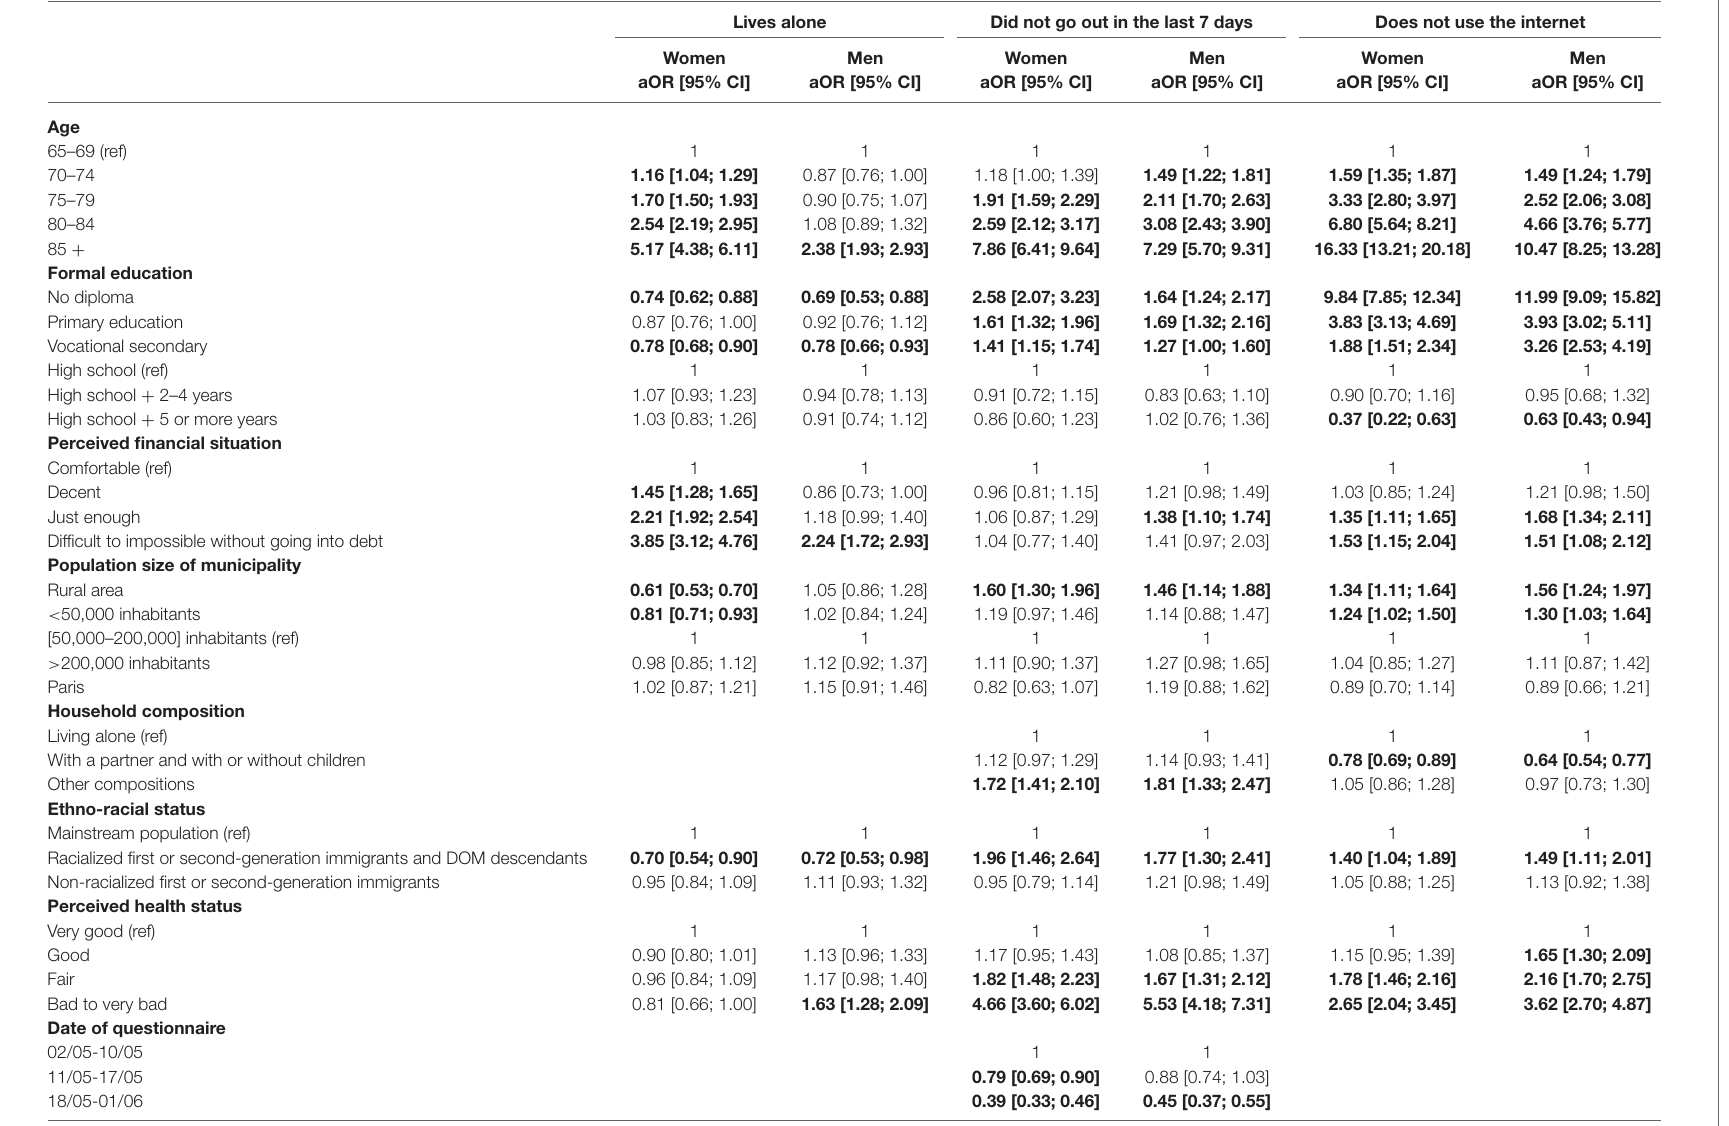
TABLE 2 | Logistic regressions of living alone, not having gone out in the past week and never using the internet, by gender. Lives alone Did not go out in the last 7 days Does not use the